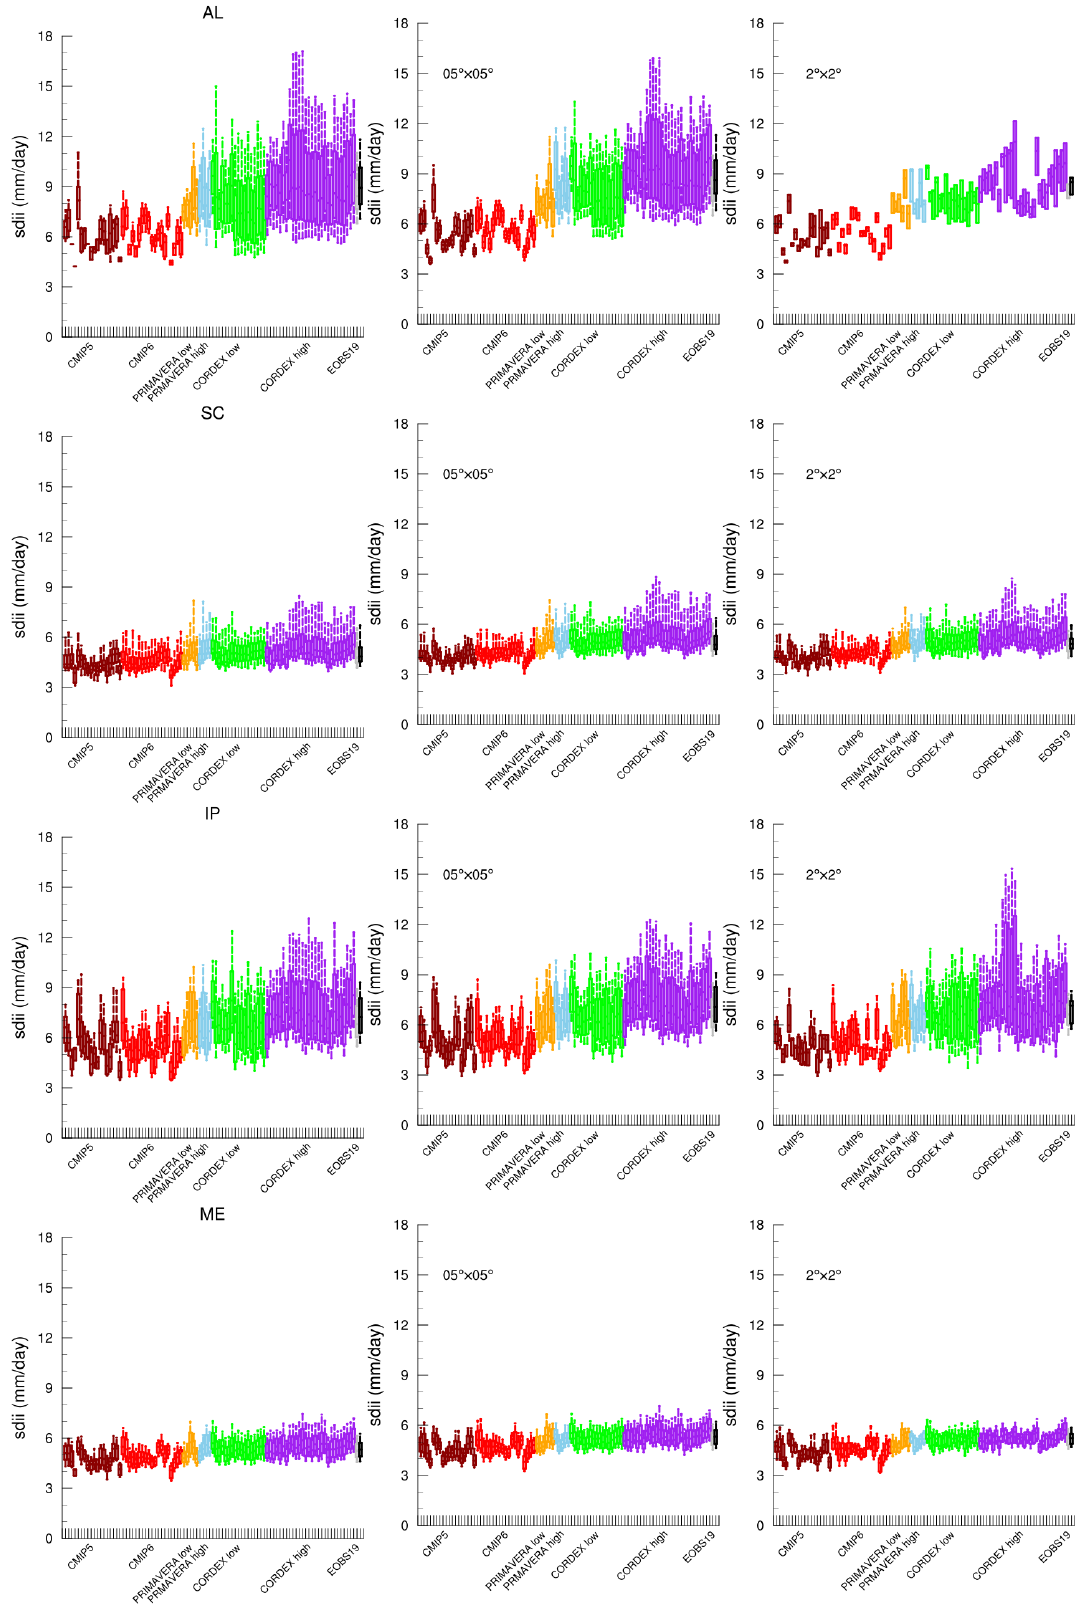
Figure 8. Same as Fig. 7 but for the simple precipitation intensity index (SDII, mmd − 1